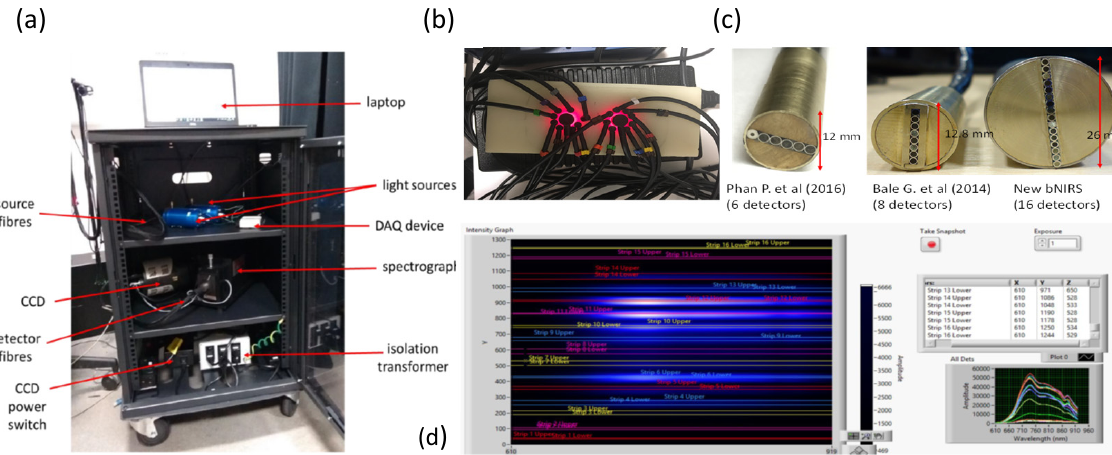
Figure 5. ( a ) Picture of the 16 detector bNIRS system (only 14 detectors used); ( b ) Picture of source and detector fibres on a solid phantom; ( c ) Detector ferrule comparison from previous instruments Phan P. et al. (2016) (16), Bale G. et al. (2014) (14) and current instrument; ( d ) Image of the software acquisition illustrating the CCD binning for each detector.